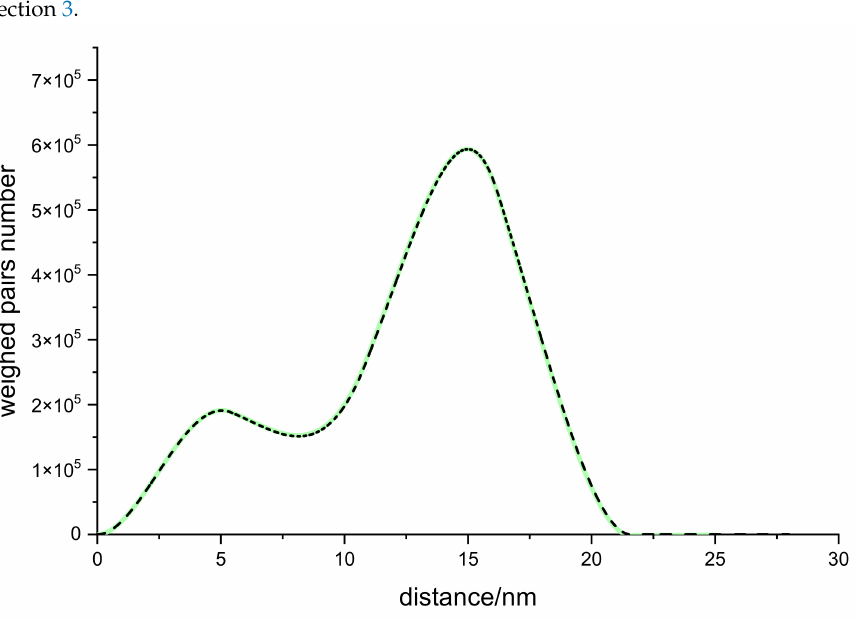
Figure 3. Histogram of the inter-particle distances of the system in Figure 2. Computed results (dashed black); numerical inverse Fourier transform of the analytical function (solid